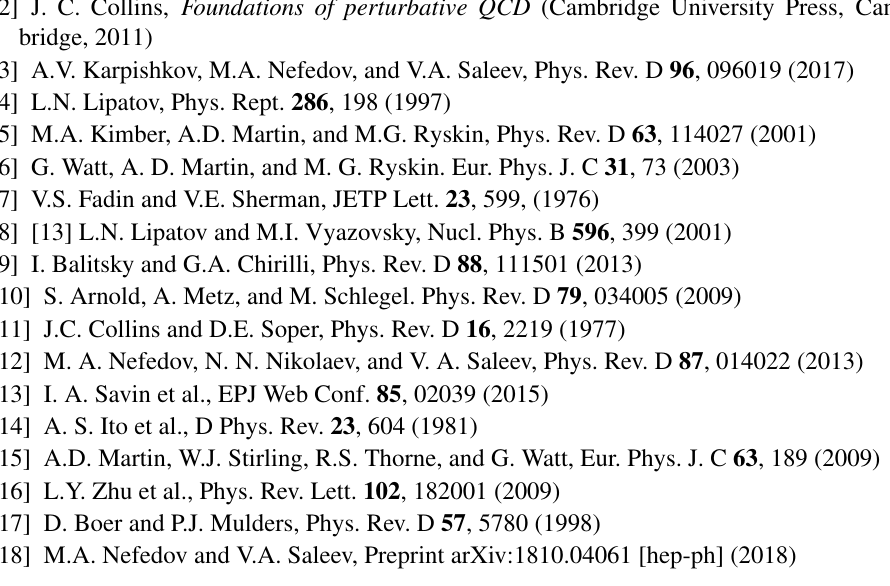
Figure 4. Predictions for unpolarized Drell-Yan SFs F (1) UU , F (2) UU and F (cos2 φ ) UU in pp -collisions at GeV. Solid lines with uncertainty bands – PRA